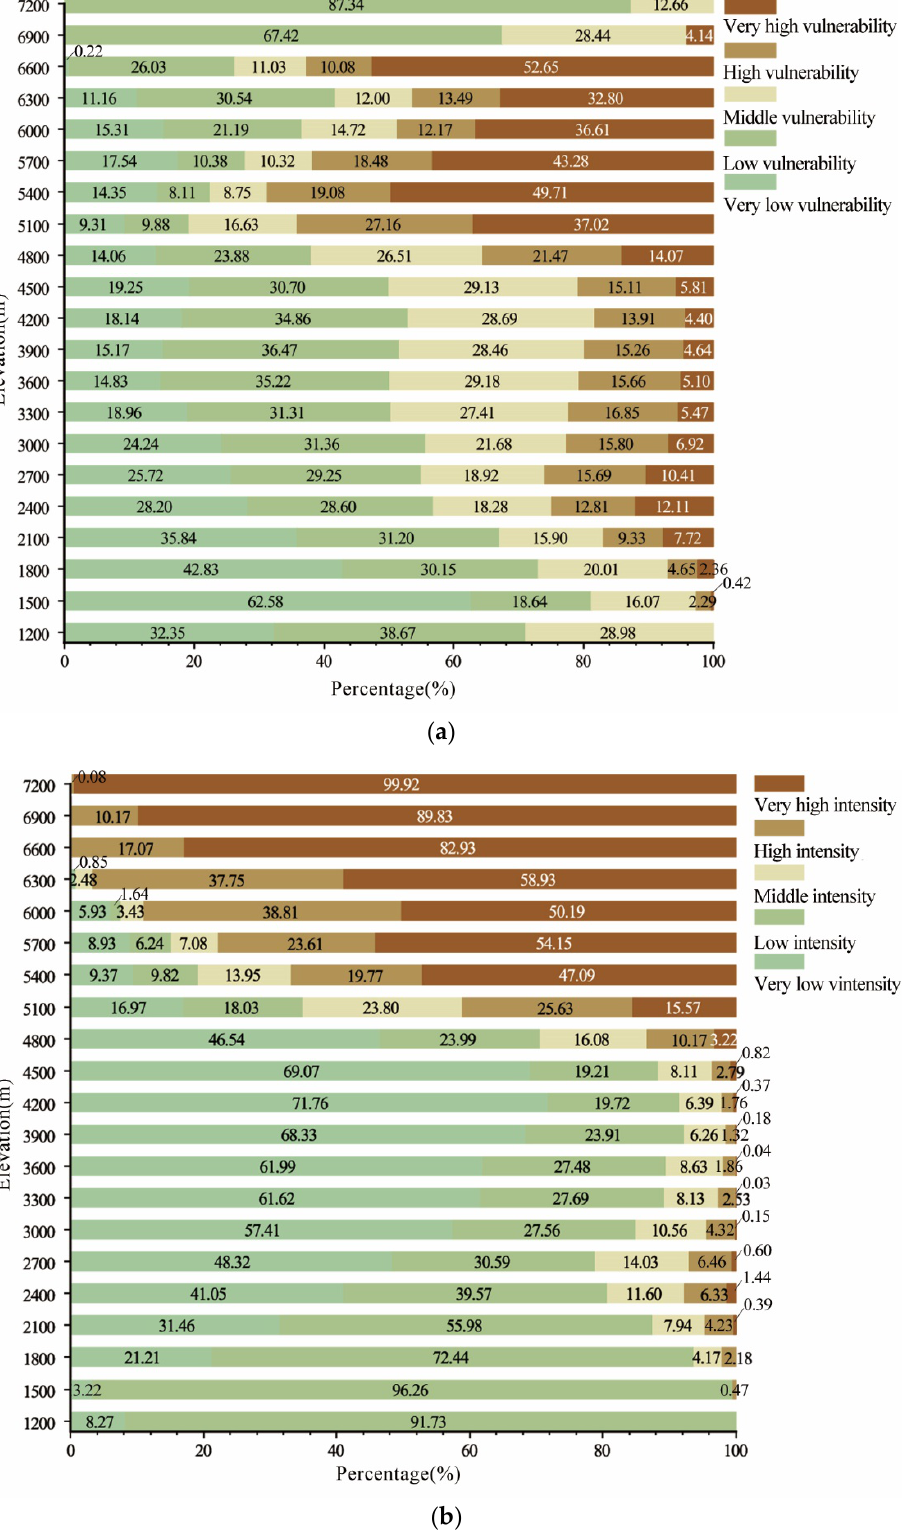
Figure 6. ( a ) . LVI distribution map of different elevation zones. ( b ). LHAI distribution map of different elevation zones.